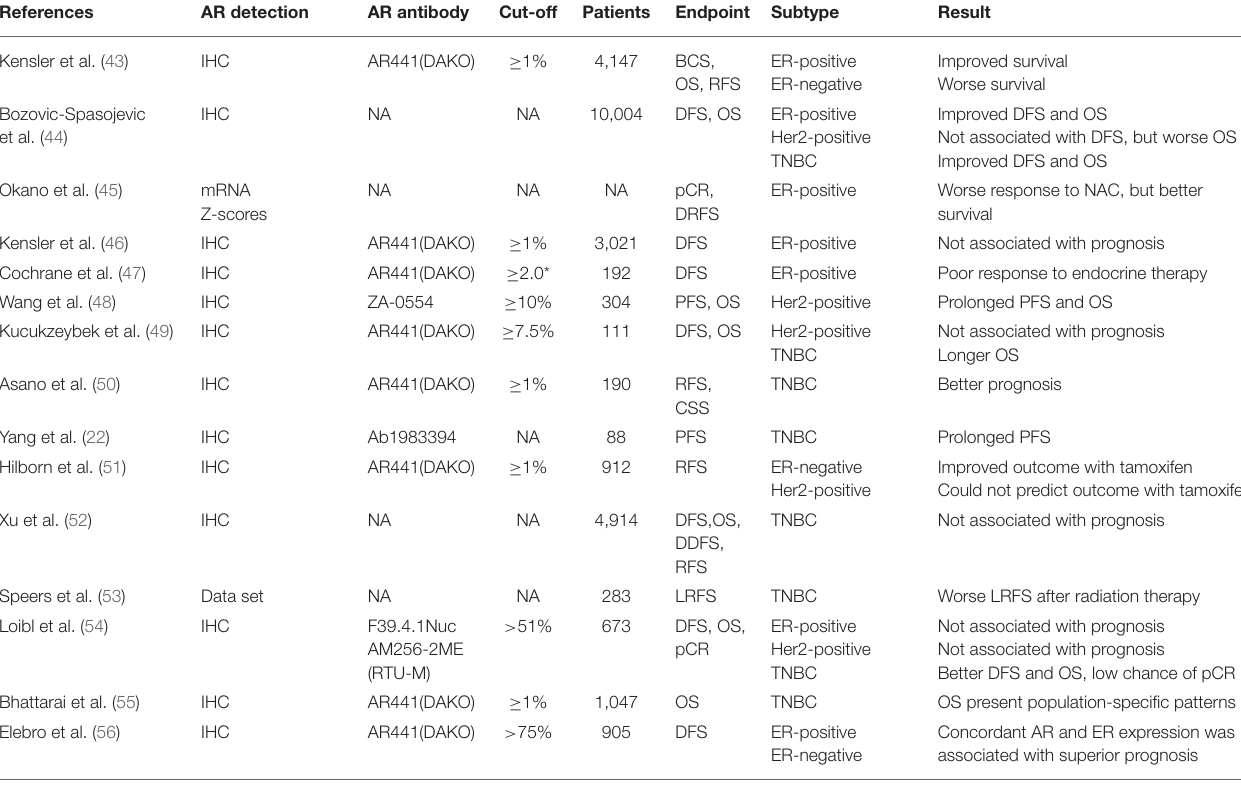
TABLE 1 | Prognostic value of AR in different breast cancer